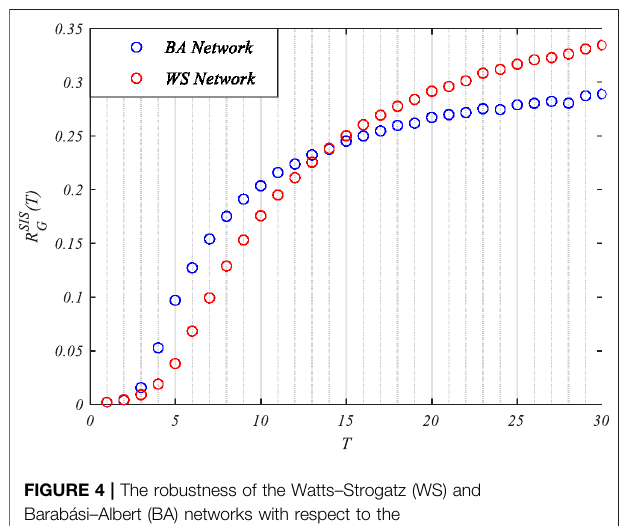
FIGURE 4 | The robustness of the Watts – Strogatz (WS) and Barabási – Albert (BA) networks with respect to the susceptible – infected – susceptible (SIS) epidemic